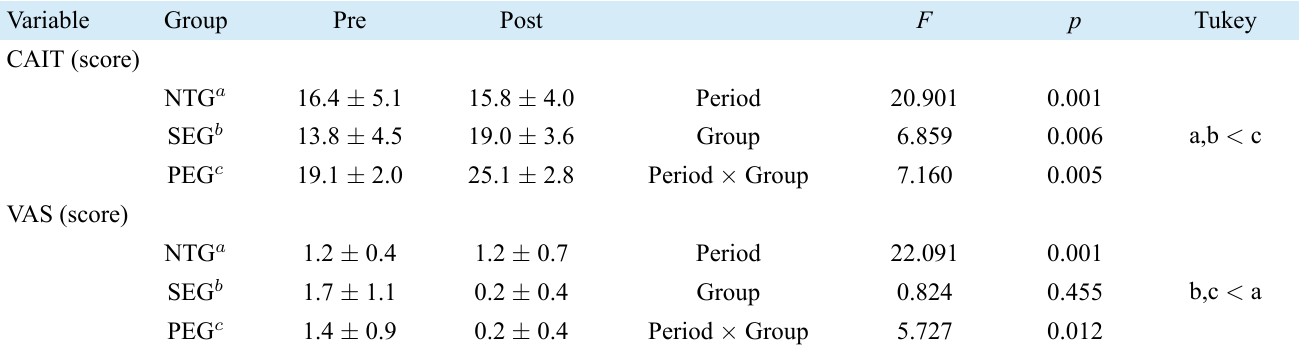
TABLE 3. Changes in ankle instability and